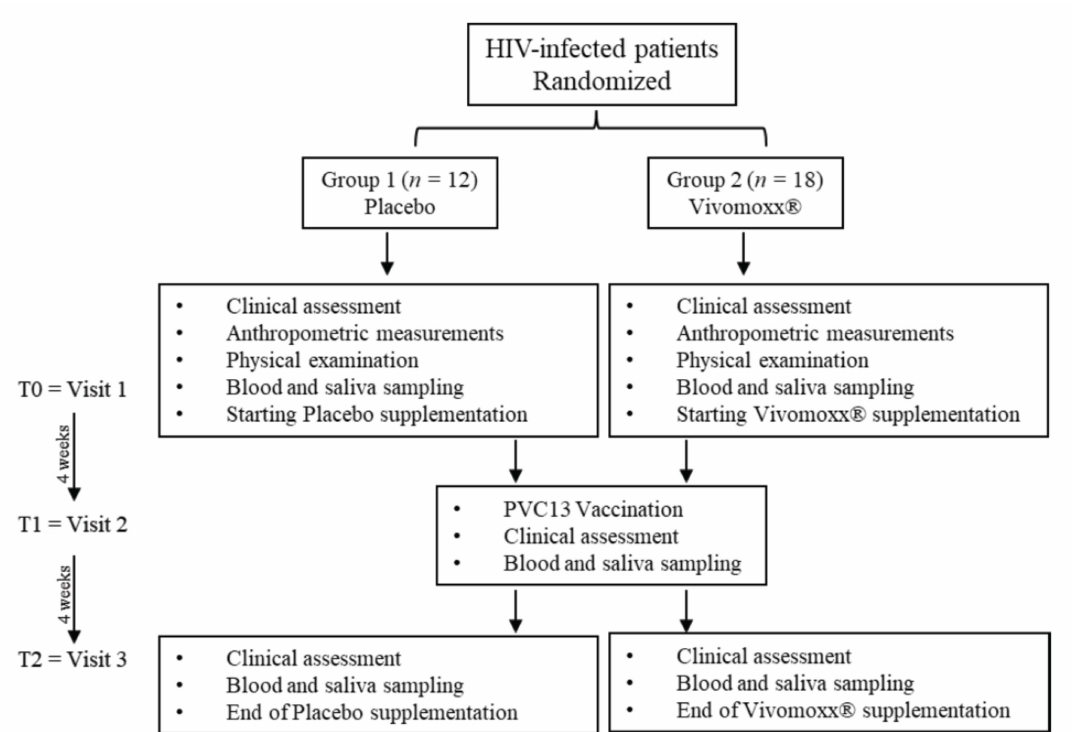
Figure 1. Study design flow chart. Graphical description of randomized